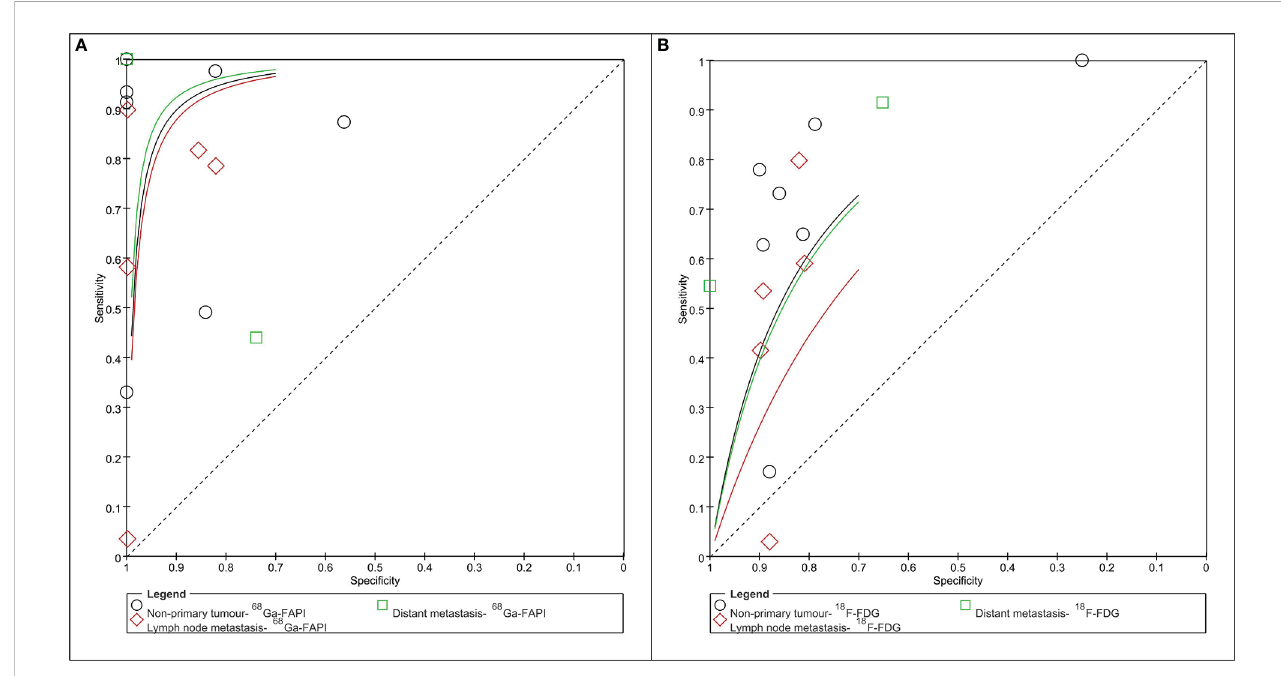
FIGURE 4 Summary receiver operator characteristic graph of 68 Ga-PAFI (A) and 18 F-FDG (B) PET/CT for non-primary tumor (lymph node and/or distant